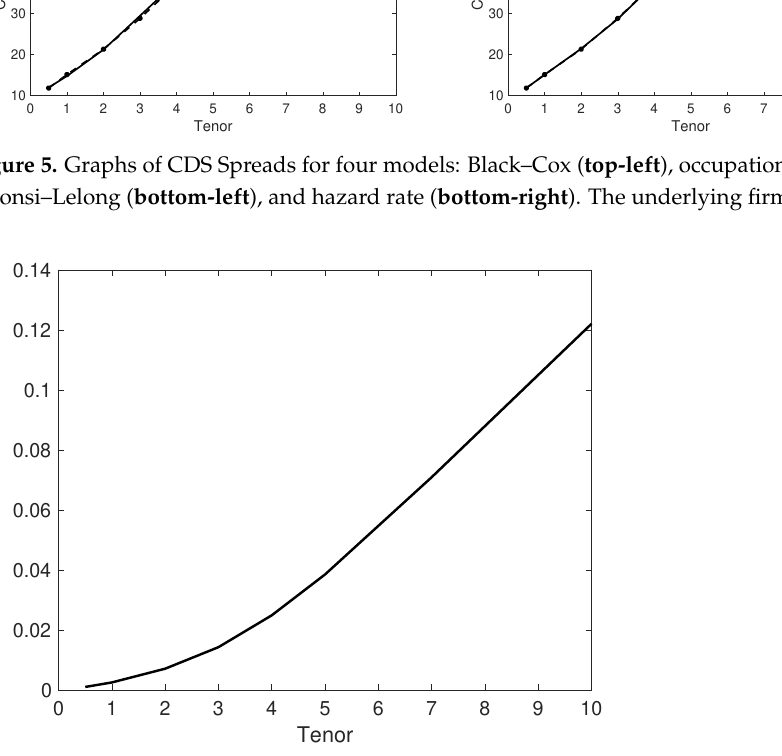
Figure 6. Implied risk-neutral probability for the hazard rate model (the underlying firm’s value is